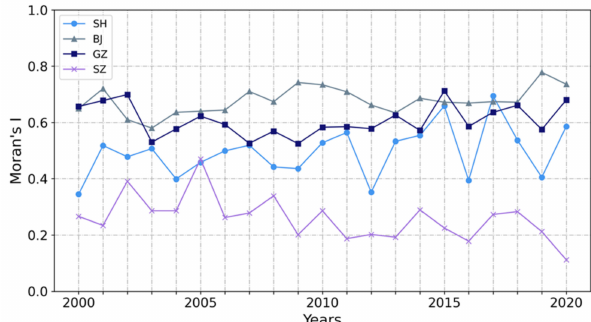
Figure 14. Line charts of annual change in Moran’s I based on 3-h extreme rainfall events in study